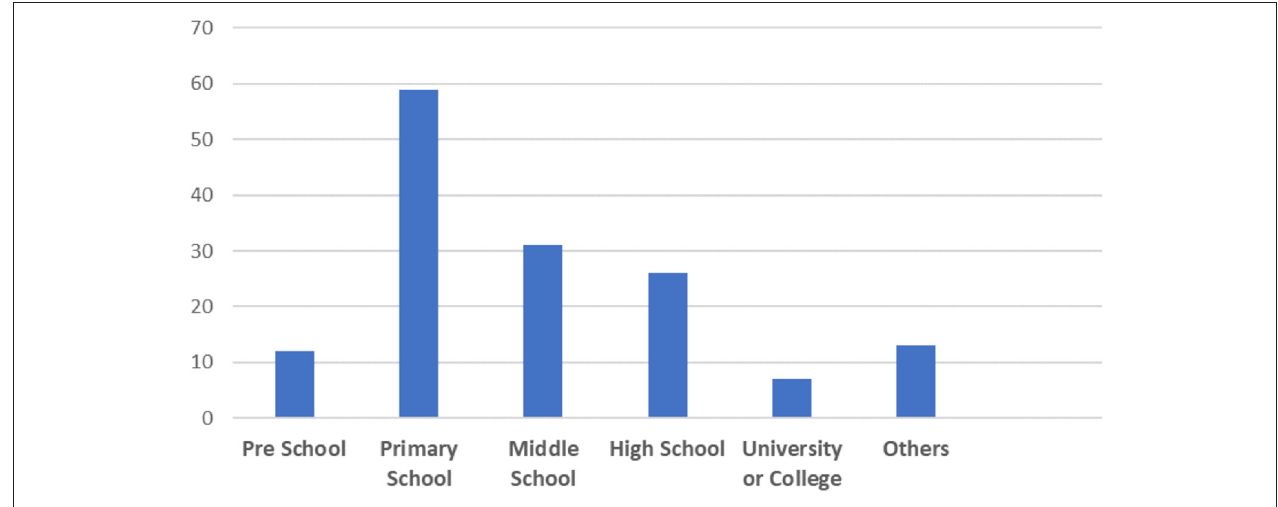
FIGURE 3 | Distribution of the reviewed studies by education level.